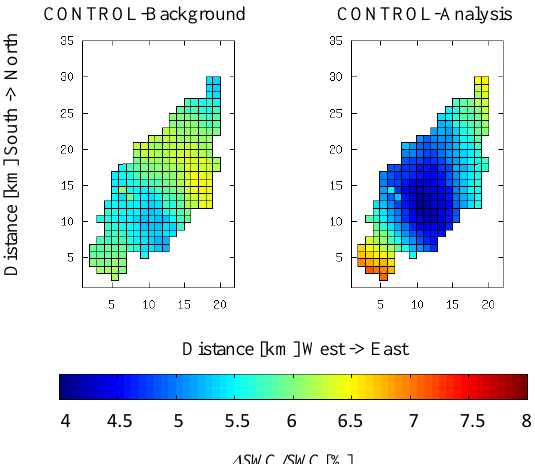
Fig. 9. The difference in soil-water content (SWC) of each grid cell relative to the CONTROL SWC of each grid cell for the initial time t =0 (5 May 1997) for the background and analysis. The anal- ysis at t =0 was obtained assimilating streamflow from the CON- TROL model simulation from Pforzheim from t =0 to t =56h with a 0.5 hourly timestep.